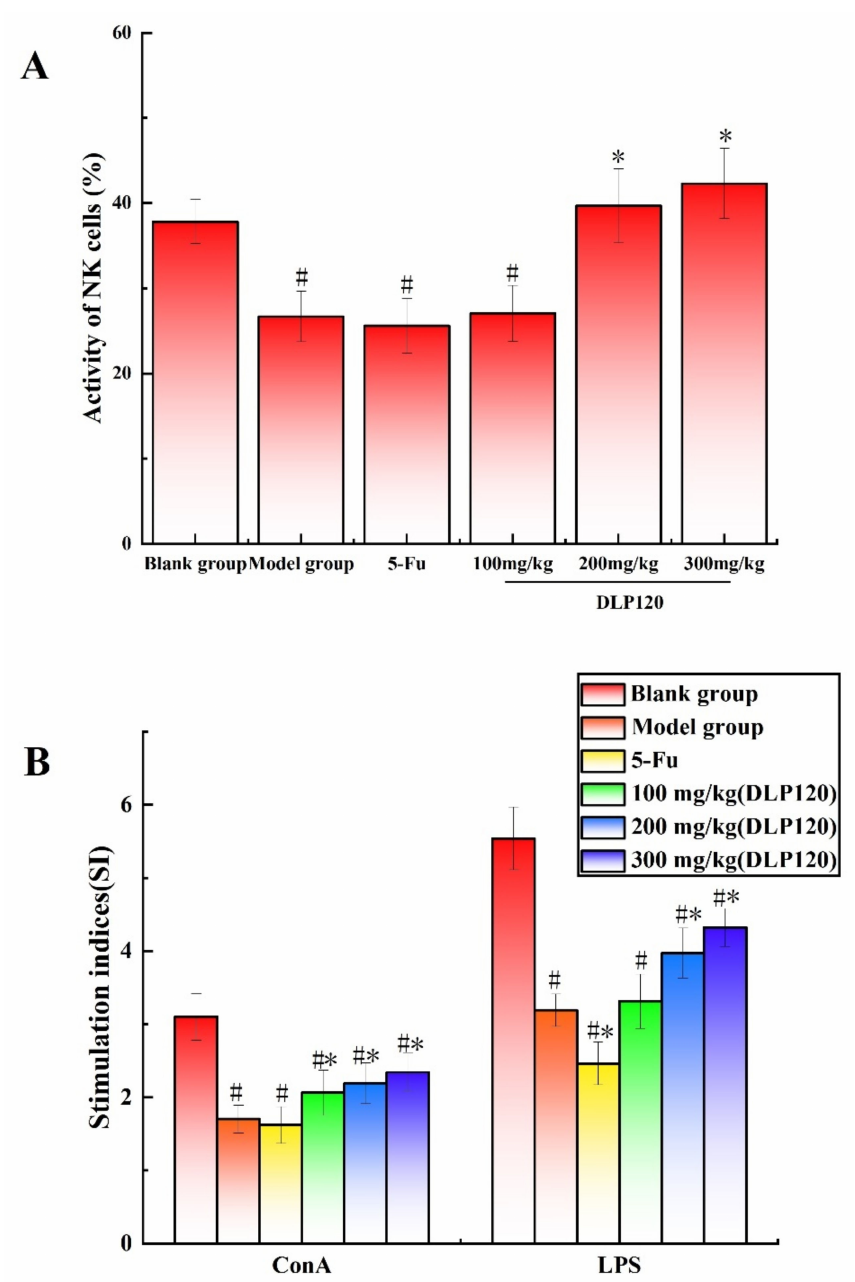
Figure 3. Effects of DLP120 on NK cells ( A ) and lymphocytes ( B ) of H22 tumor-bearing mice. Note: # p < 0.05, compared to blank group; * p < 0.05, compared to model